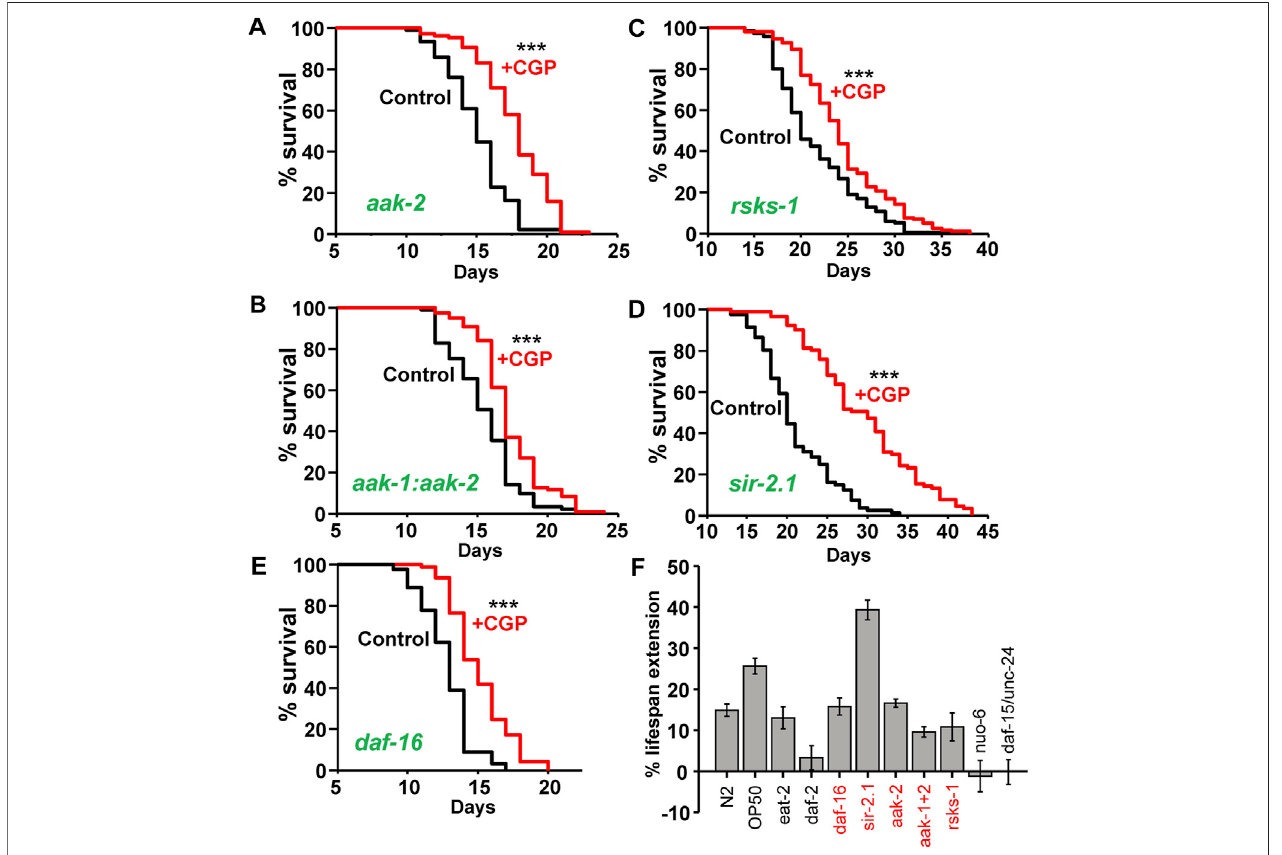
FIGURE1| EffectofCGP37157onthelifespanofseveral C.elegans mutants.The fi gureshowstypicalparallelcontrolvs.druglifespancurvesobtainedindifferent C. elegans mutants, as indicated in the panels. CGP37157 concentration was 50 µM. Panel (F) shows a summary of the mean changes in survival induced by CGP37157inseveral C.elegans mutants, includingthoseof Figure1 (inred)andothersreportedpreviously(García-Casasetal.,2019).Thetrialsshowncorrespondto those marked in bold in Supplementary Tables S1, S2 (more details ofall the assays in Supplementary Tables S1, S2 ). *** p < 0.001 in the Kaplan-Meierstudy (log-rankroutine). SupplementaryTablesS1,S2 showthatallthetrialsineverymutantfoundsigni fi cantdifferenceswith/withoutCGP37157with p < 0.001,exceptfor the case of the rsks-1 mutant, where two trials found differences signi fi cant with p < 0.001, one with p < 0.05 and one found no signi fi cant